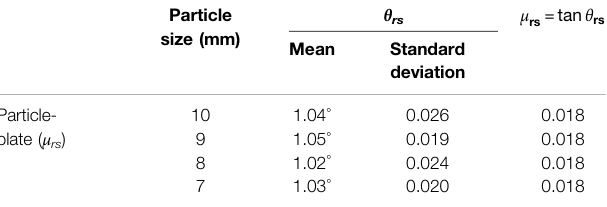
TABLE 5 | The test results of rolling friction coef fi cient of smooth glass particles.